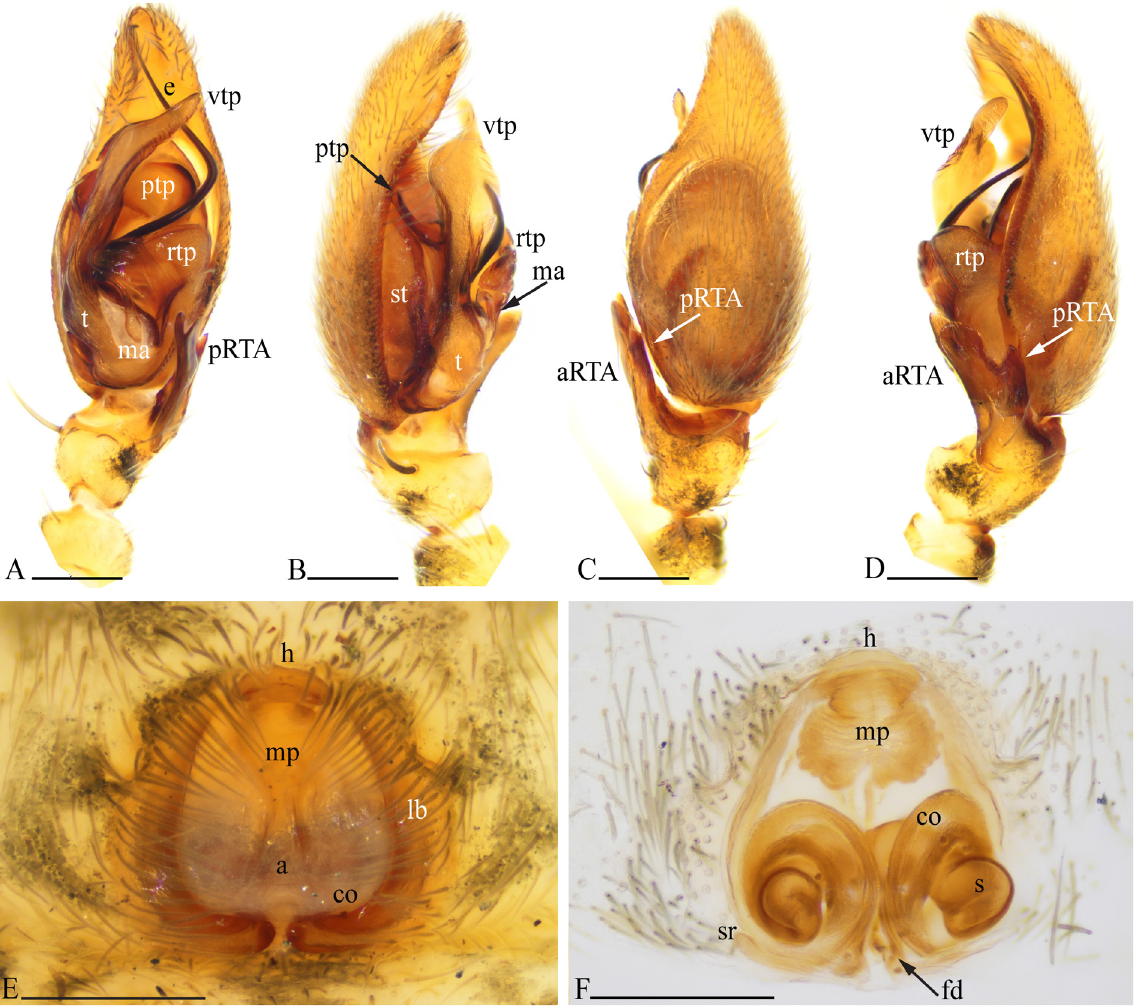
Fig. 7. Anyphaena adnani sp. nov. A–D . Paratype, ♂ (CNAN-T01545). E–F . Paratype, ♀ (CNAN- T01546). A . Pedipalp, ventral view. B . Pedipalp, prolateral view. C . Pedipalp, dorsal view. D . Pedipalp, retrolateral view. E . Epigynum, ventral view. F . Epigynum, dorsal view. Scale bars: 0.2